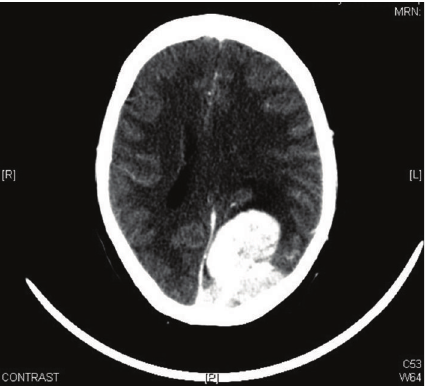
Figure 5: Computed tomography of brain showing multiple intra- and extracranial enhancing lesions at left occipital, left parietal subdura ( 5.6 × 3.5 cm) with midline shift and vasogenic edema, and right